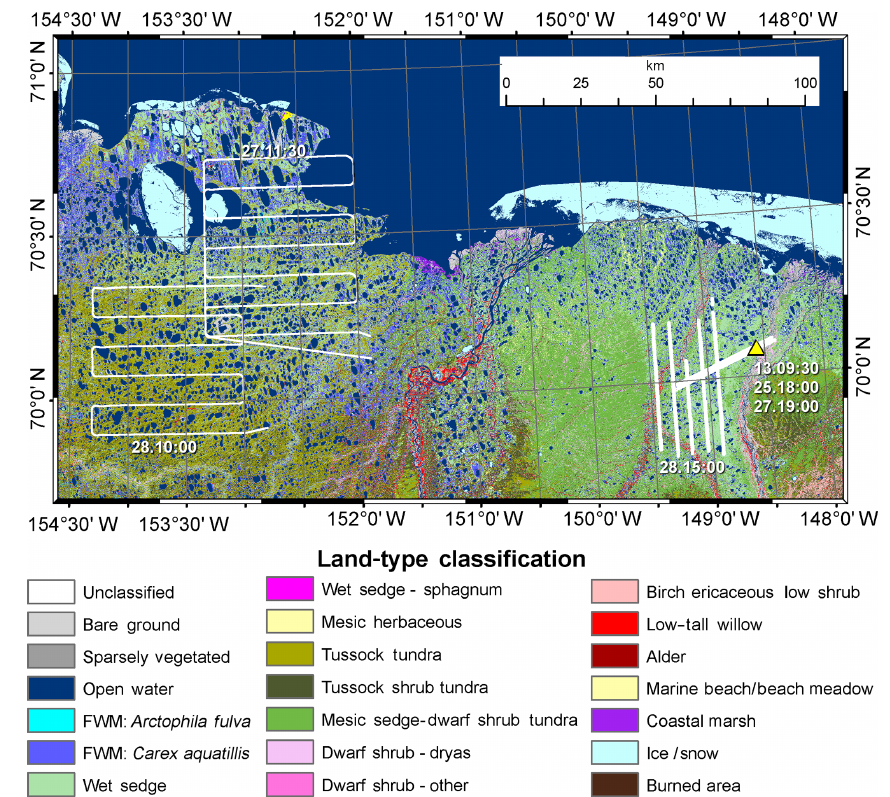
Figure 2. Six flight tracks flown by FOCAL during August 2013 are shown in white. Flights are given in the figure as DD.HH:MM, where DD is the date in August and HH:MM is the time (UTC − 10) of the middle of the flight rounded to the nearest half-hour. Flight tracks are shown only for the portions flown within 25m of the ground. The underlying chart gives the NSSI-assigned land-cover class produced from LandSat 30m Thematic Mapper data. The yellow triangle locates the NOAA/ATDD flux tower. Table 1. Flights used in the analysis along with location, time of day, mean air temperature, and surface land